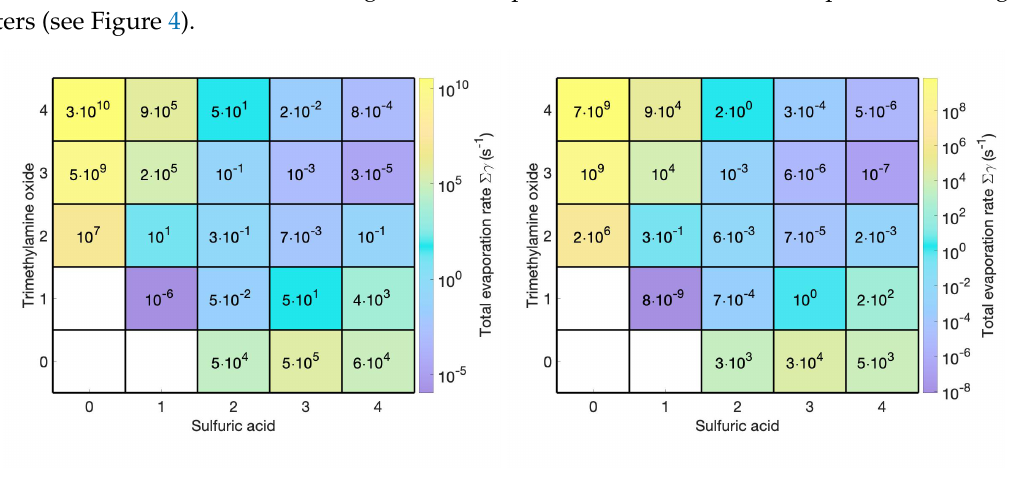
Figure 4. Overall evaporation rates of SA–TMAO clusters at 298.15 K ( left ) and 273.15 K ( right ). The x - and y -axes give the numbers of SA and TMAO molecules in the cluster,